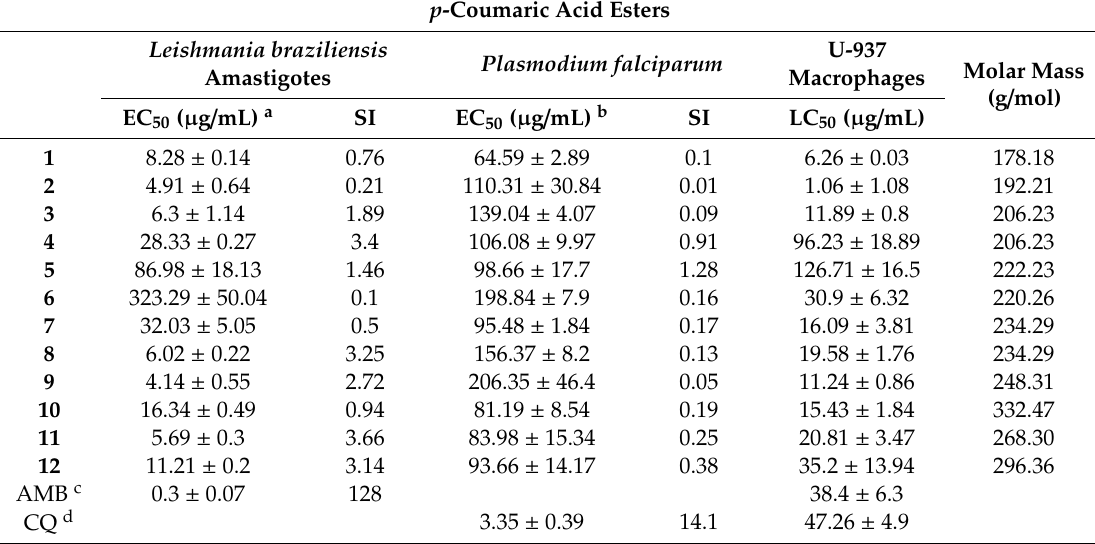
Table 1. Antileishmanial and antiplasmodial activity, cytotoxicity and molar mass of compounds 1 – 12 . p -Coumaric Acid Esters Leishmania braziliensis Plasmodium Amastigotes